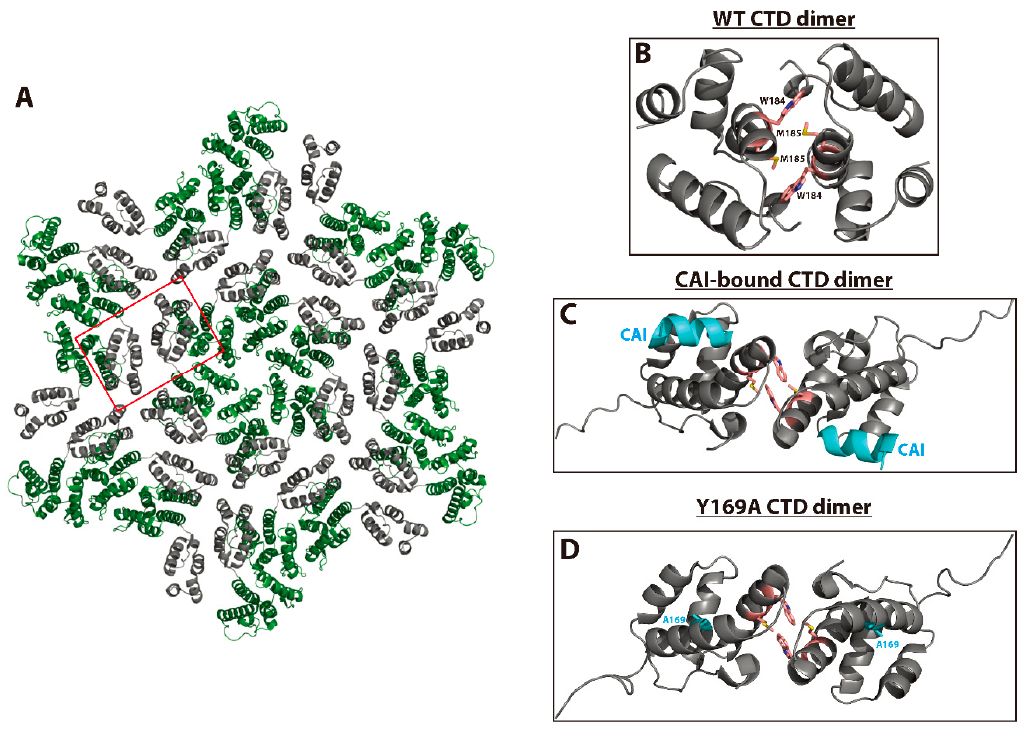
Figure 6. CAI induces aberrant dimer formation. ( A ) CA-CTD / CA-CTD dimerization within the mature CA lattice (red box) is an important interhexameric contact that holds mature CA hexamers together (PDB accession 5MCX). ( B ) WT CA-CTD dimer formation is mediated by two key amino acid residues: W184 and M185 (PDB accession 1A43). ( C ) CAI-binding to the CA-CTD allosterically induces the formation of an aberrant dimer in which W184 and M185 shift positions relative to the WT dimer (PDB accession 2BUO). ( D ) The Y169A mutation (blue) phenocopies the effect of CAI on the conformation of the dimer interface (PDB accession 3DS2).